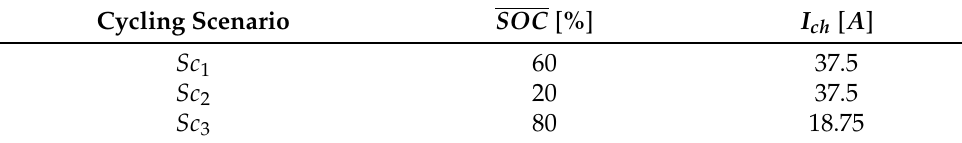
Table 2. Different operating